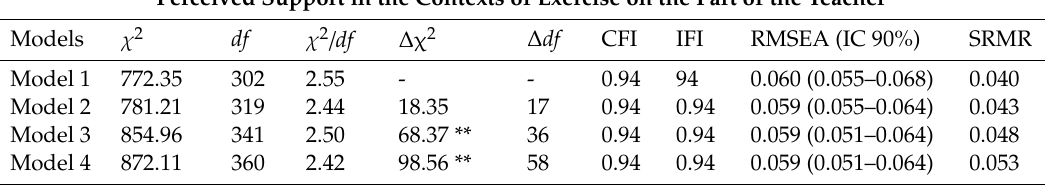
Table 3. Age Invariance